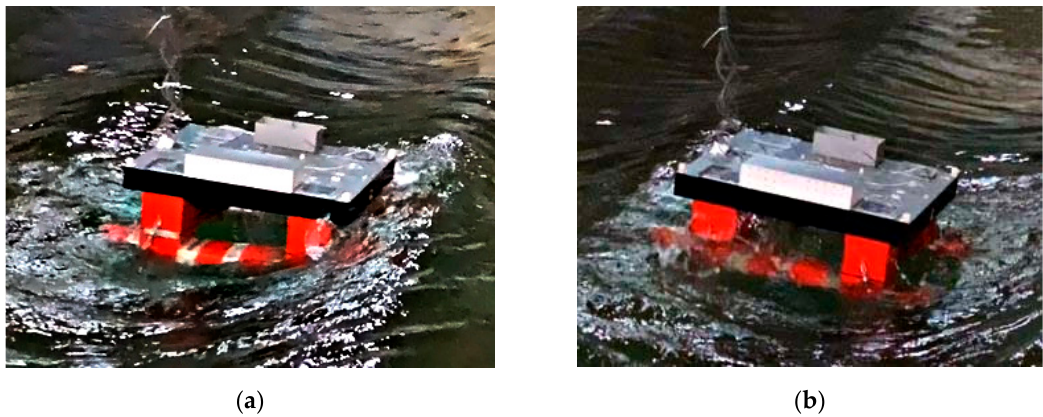
Figure 18. Experiment measurement of front and rear end column wave slamming column. ( a ) the wave slammed the front column. ( b ) the wave slammed the rear end column.